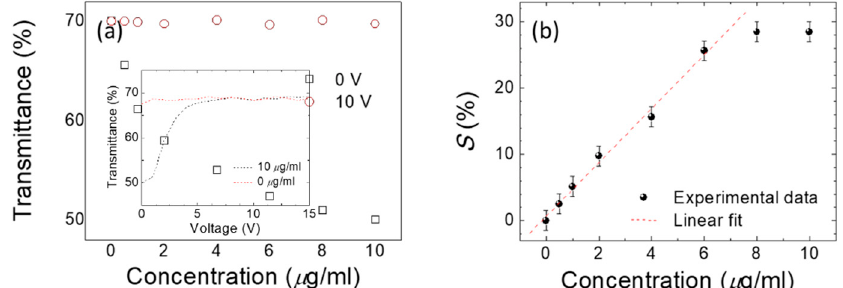
Figure 8. ( a ) Intensity of DDLCs immobilized by 0–10 µg/mL BSA concentrations under 0 and 10 V. Inset, voltage-dependent transmission spectra at DDLC cells immobilized with 0 and 10 µg/mL of BSA. ( b ) Relationship between the parameter of standard S % (the wavelength transmittance-related loss) and BSA concentrations in DDLC cells.